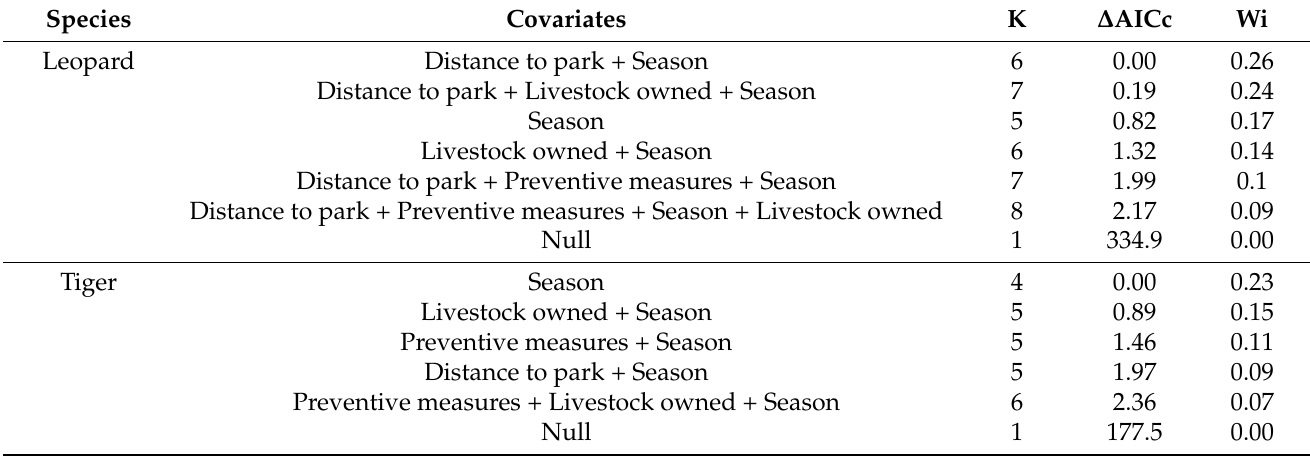
Table 2. Generalized linear models to identify factors related to livestock depredations by leopards and tigers, Bardia National Park, Nepal. Number of livestock killed was used as the response variable; total livestock owned (number); preventive measures (number of techniques used to deter tigers and leopards, 0–4). Season (number of livestock killed: fall, winter, spring, summer), park distance (near: <1 km, and far: >1 km from the park boundary). K is the number of parameters, ∆ AICc is the difference between the AICc value of the best supported model and successive models, and w i is the Akaike model weight.